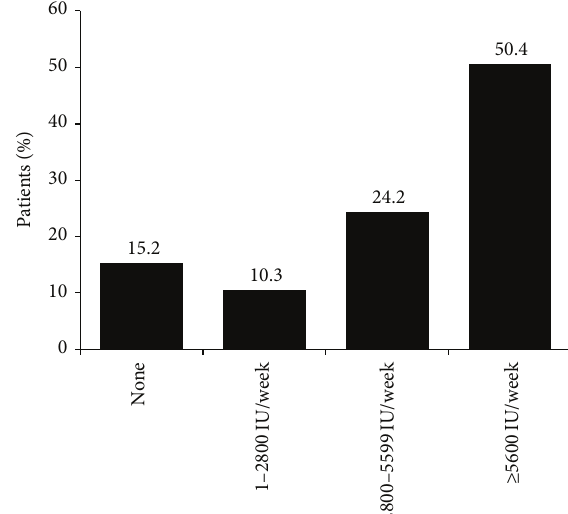
Figure 1: Level of vitamin D supplementation ( 𝑛 = 983 ). Note: numbers may not add to 100 due to